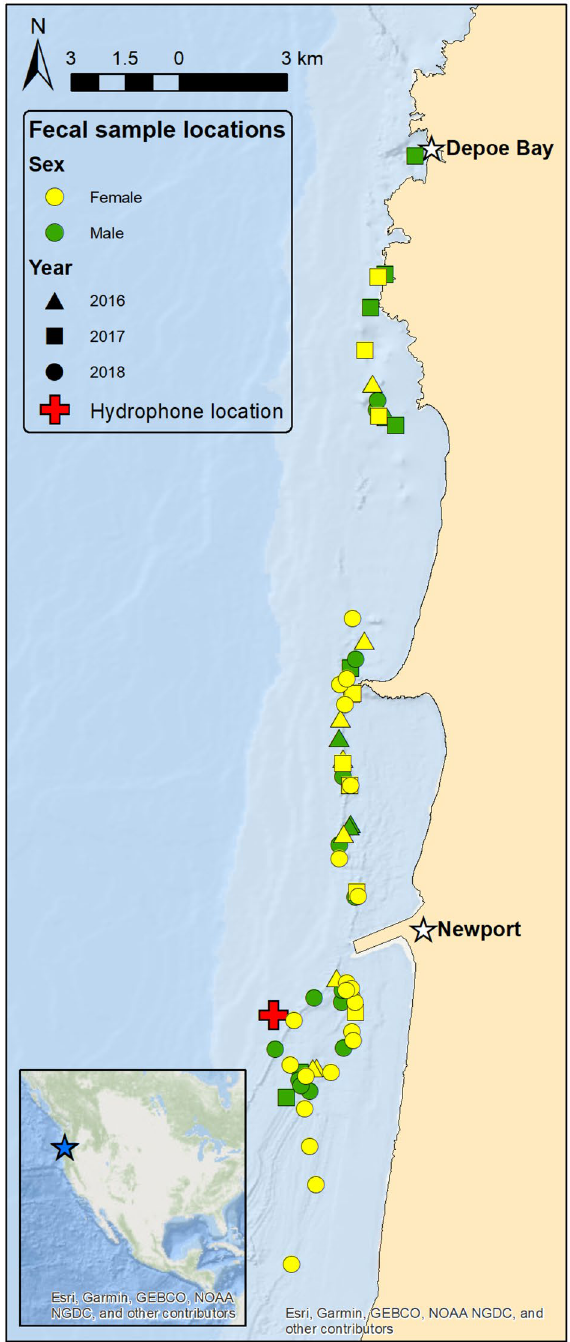
Figure 1. Location of field site off the central Oregon, USA coast (blue star on inset map), hydrophone deployment site (red cross), and gray whale fecal sample collections symbolized by color and shape to represent sex and year. The ports of Newport and Depoe Bay are represented by white stars. The Newport white star is also representing the anemometer station (NPOW3) from which the wind speed data were retrieved from. Figure created in ArcGIS software (version